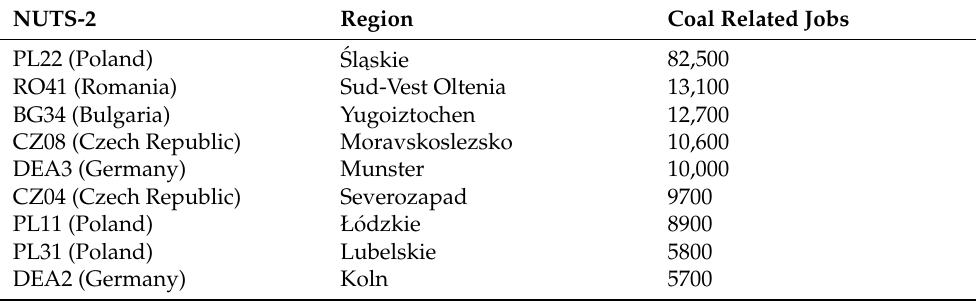
Table 1. The number of jobs created by coal mines and their subsidiaries. NUTS-2 Region Coal Related Jobs PL22 (Poland) ´Sl ˛askie 82,500 RO41 (Romania) Sud-Vest Oltenia